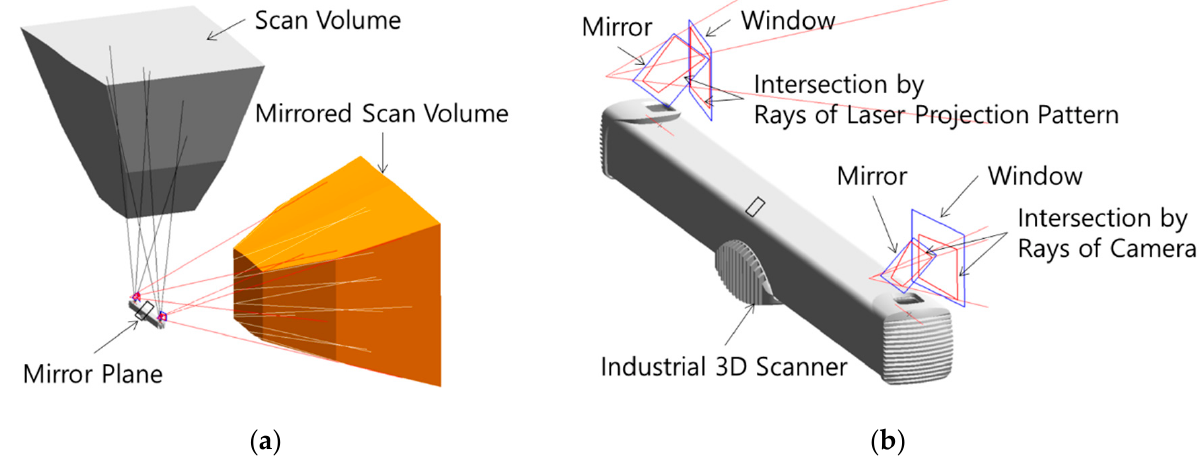
Figure 3. Optical Path Configuration: ( a ) Scan Volume; ( b ) Boundaries of Mirror and Window.